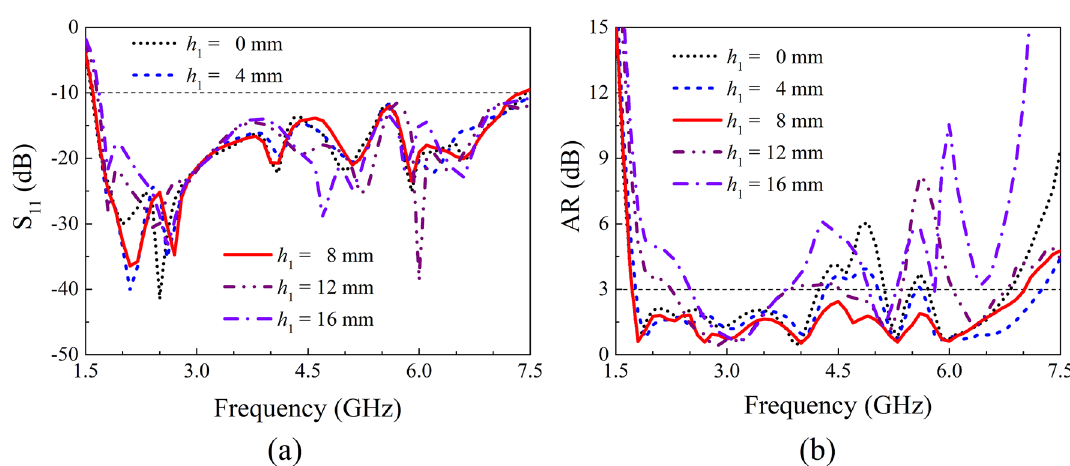
Figure 8. Effect of different h 1 on S 11 and AR, respectively. ( a ) S 11 , ( b )